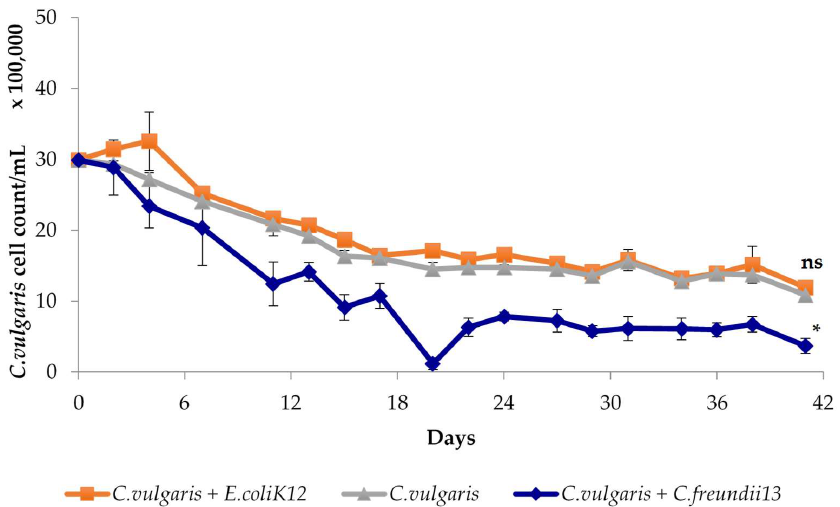
Figure 3. Influence of E.coli K12 and C.freundii sp. isolate 13 on microalgae C. vulgaris cell counts in the BBM media after 40 days of microaerophilic incubation without light. Error bars represent standard deviation. An asterisk notation ( * ) indicate a statistically significant di ff erence of the whole 40-day dataset, compared to the control algae dataset (grey), while (ns) notation point to the non-statistically significant di ff erence between a dataset and a control algal dataset. See text for more